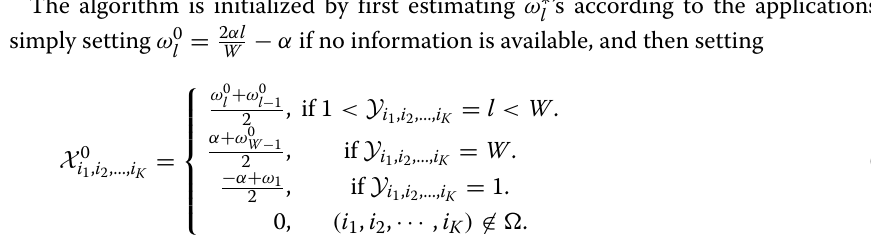
algorithm sets ω l = min (ω l + 1 − κ l + 1 , α upper ) if ω l > min (ω l + 1 − κ l + 1 , α upper ) , and